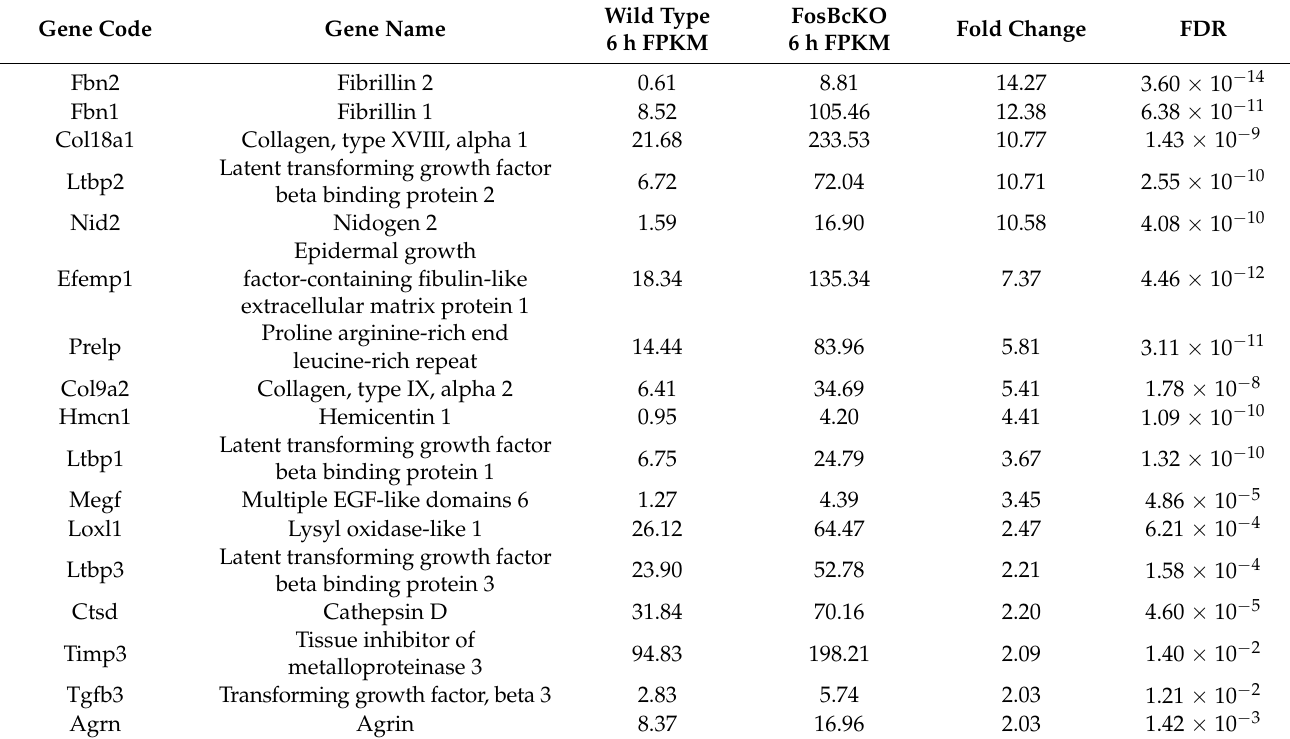
Table 9. Genes encoding zonule components that are upregulated in FosBcKO LECs at 6 h PCS compared to